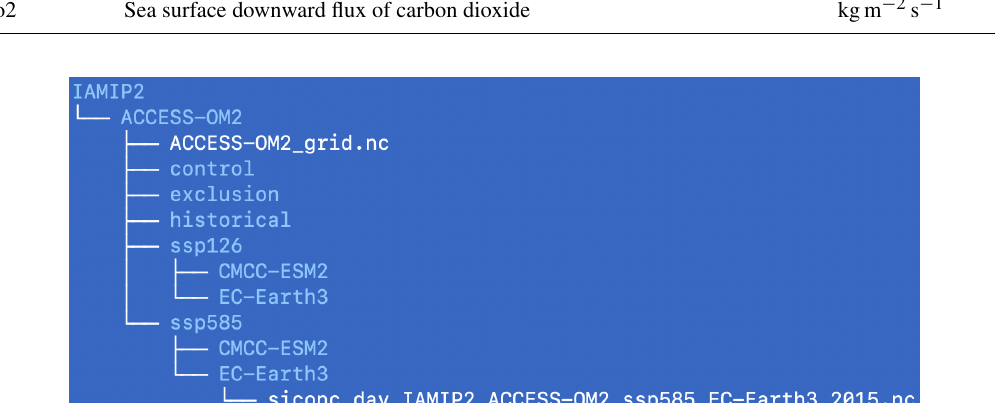
Figure 5. An example file tree diagram for the IAMIP2 output. Blue denotes the directories and white denotes files. A grid file (e.g., ACCESS-OM2_grid.nc) must be provided and placed under the model directory (e.g., IAMIP2/ACCESS-OM2/). Each diagnostic file (e.g., siconc_day_IAMIP2_ACCESS-OM2_ssp585_ EC-Earth3_2015.nc) contains the output of a variable for a